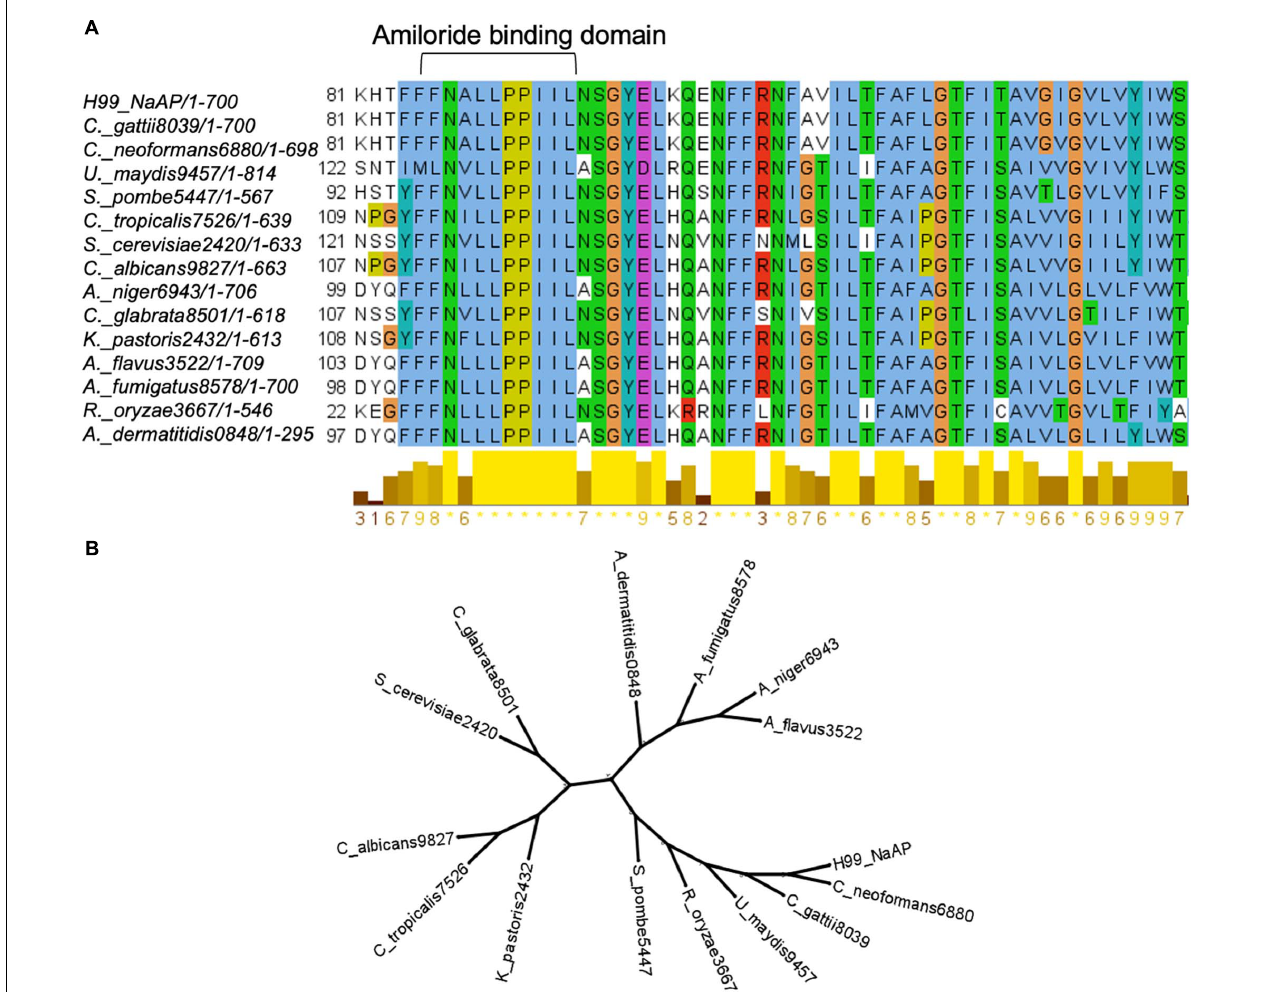
FIGURE 5 | The intracellular Na + /H + exchanger, Nhx1, in fungi. (A) Amiloride binding domain in Nhx1 is highly conserved among fungi. (B) Phylogenetic analysis of Nhx1 protein sequences from 13 fungal species and S. cerevisiae indicates the relative conservation of Nhx1 among these species.